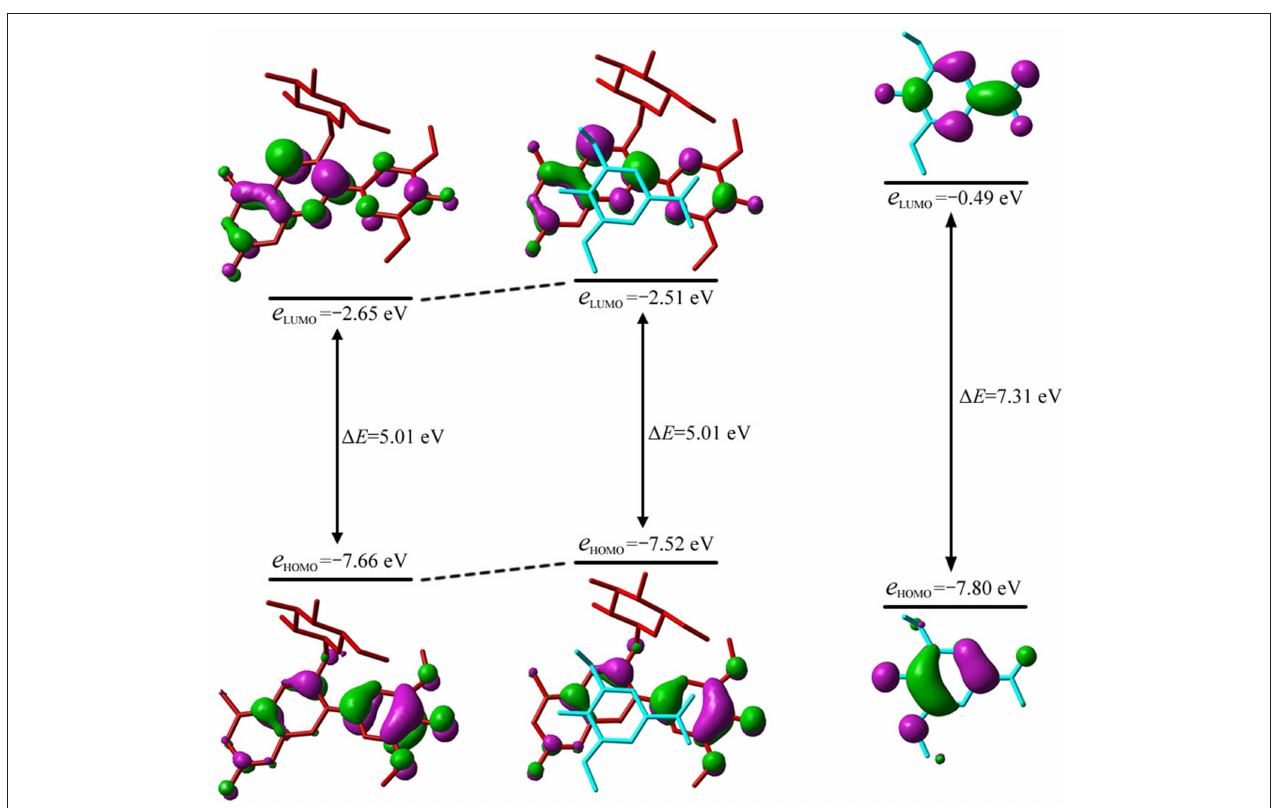
FIGURE 4 | Molecular orbital correlation diagram of oenin, conformer 1 and syringic acid. A tube molecular representation was adopted for oenin (red) and syringic acid (cyan).